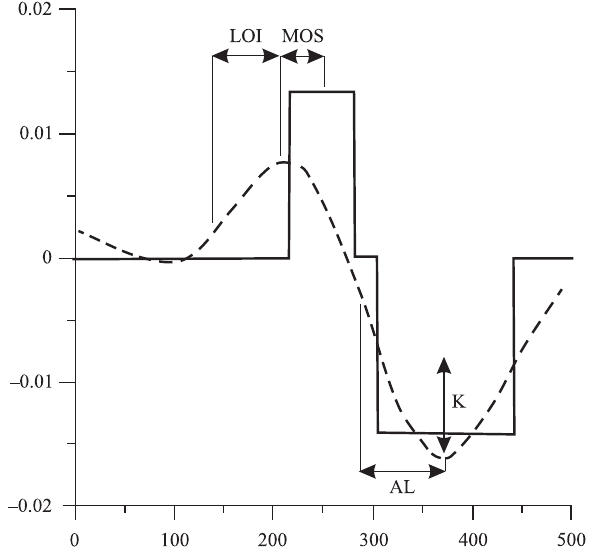
Fig. 2. Relationship between LOI, MOS, AL and K